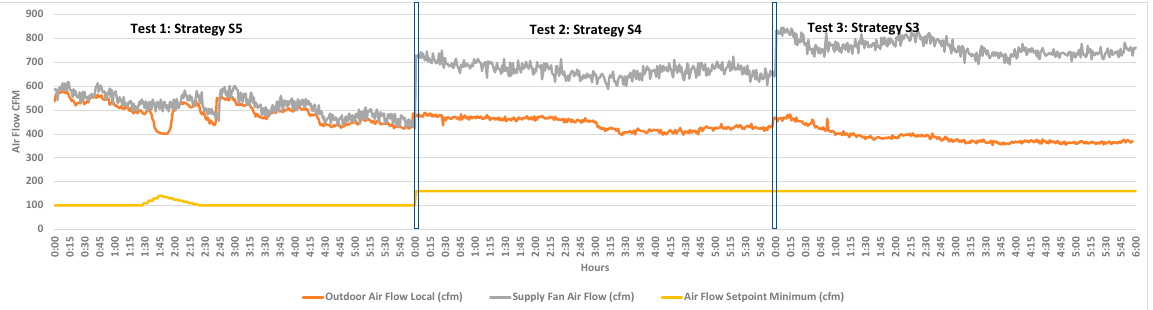
Figure 12. OAT and SAT when various strategies were applied.